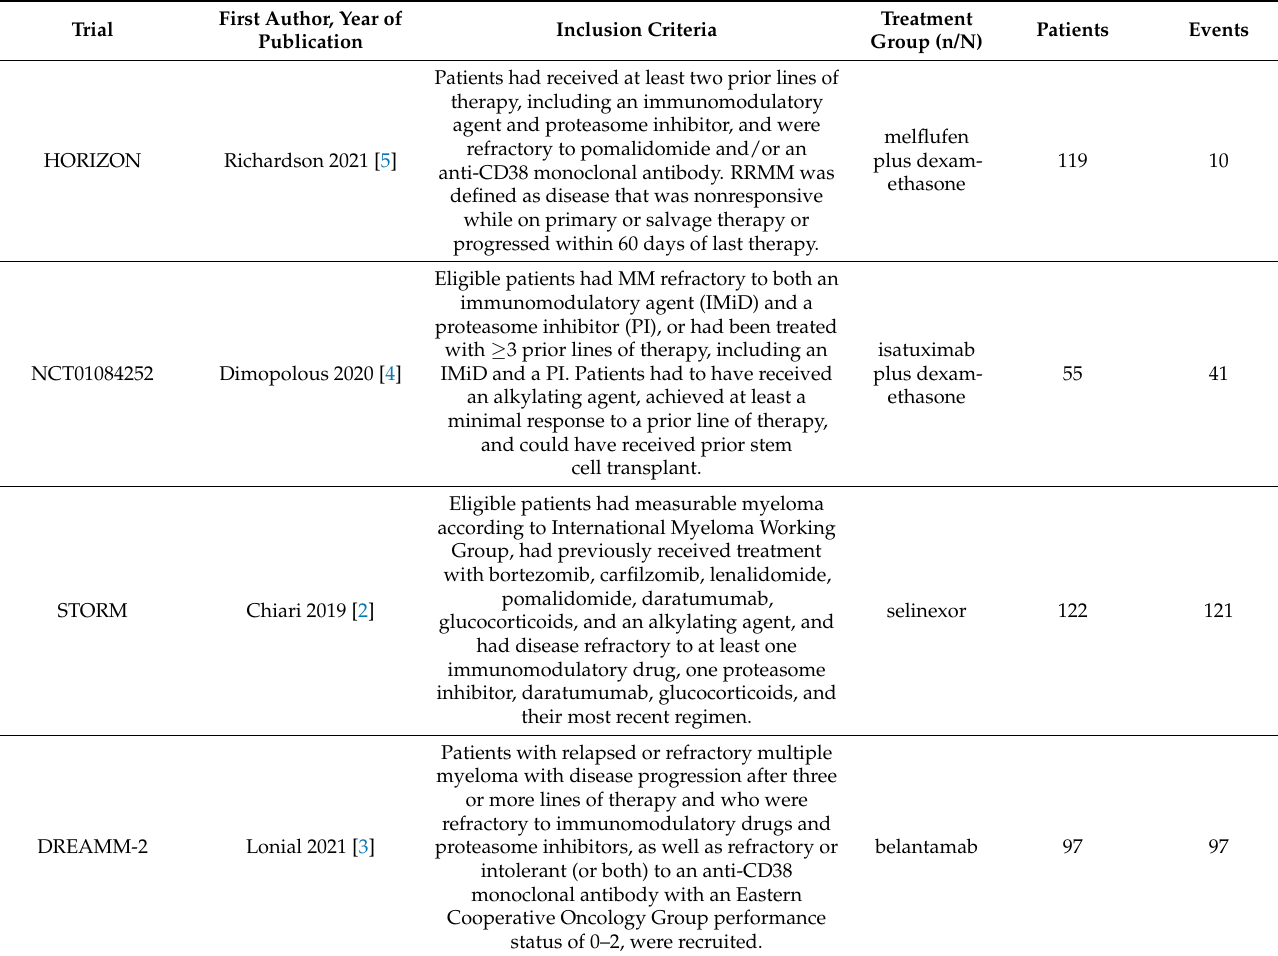
Table 1. Characteristics of the six studies included in our